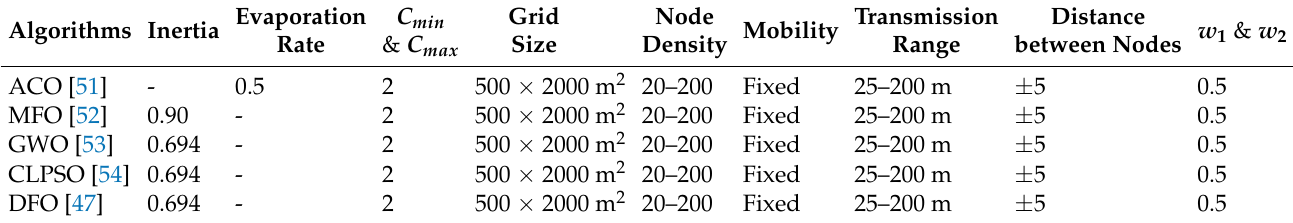
Table 1. Simulation parameters for algorithms.